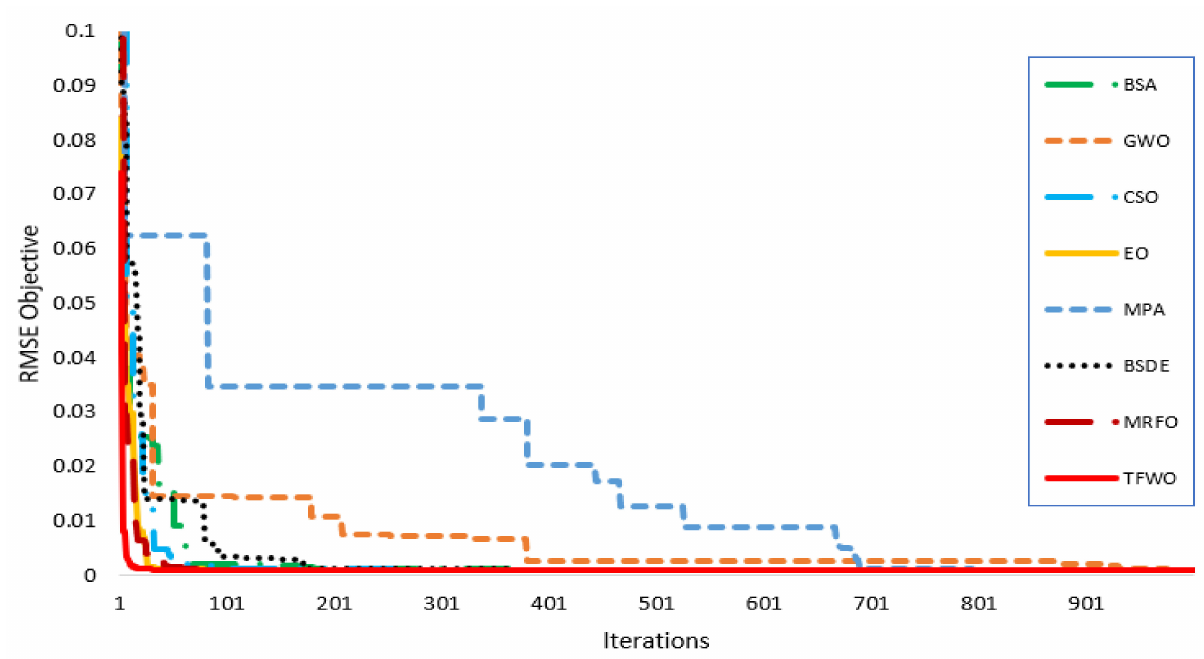
Figure 5. Convergence curves for R.T.C. France SDM.